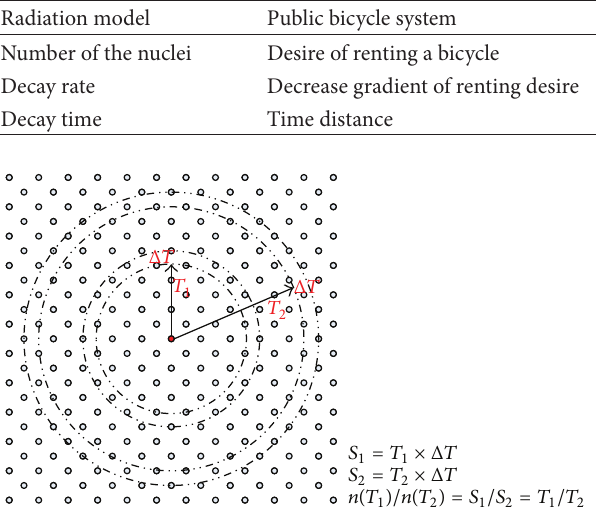
Figure 4: Analysis of the proportional relation of the number of pairs of stations 𝑛(𝑇) and 𝑇